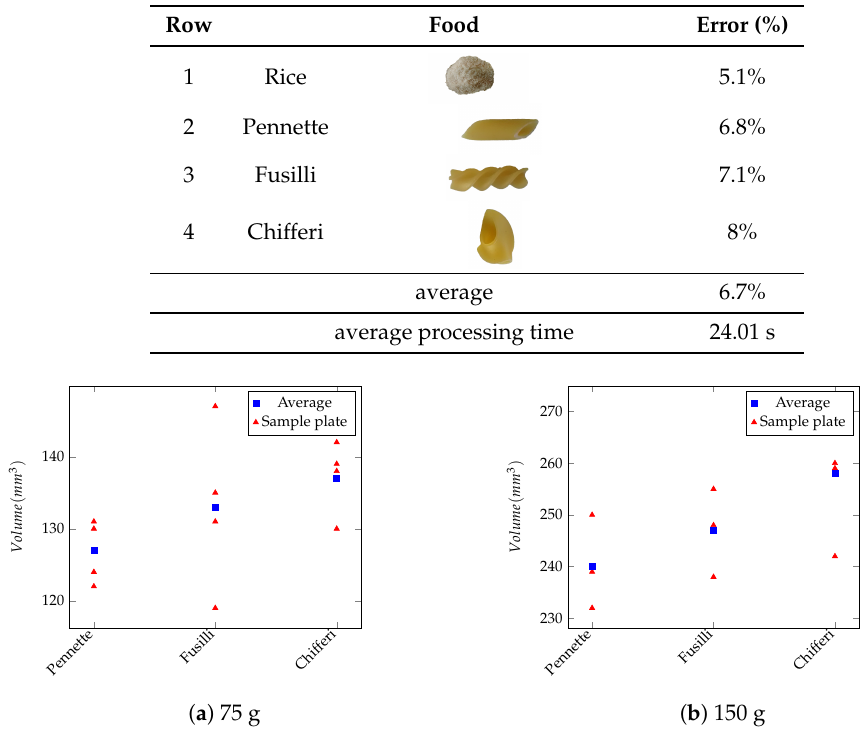
Table 2. Error rate in the reconstructed models’ volume estimations for non-solid shapes.